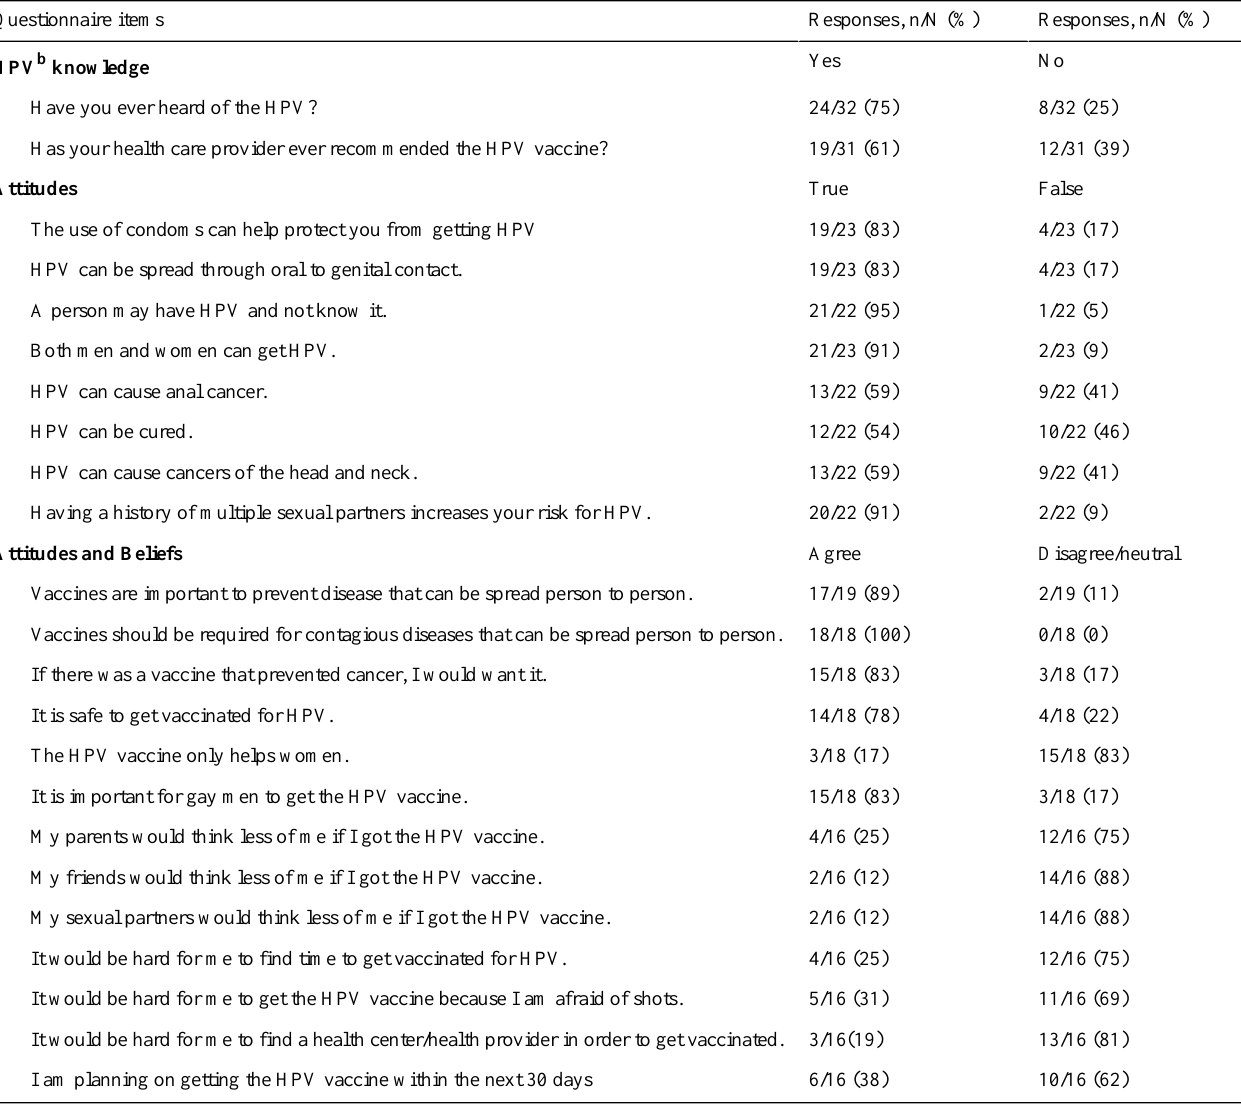
Table 1. Questionnaire data on HPV knowledge, attitudes, and beliefs.